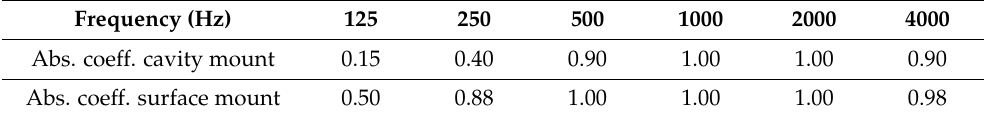
Table 4. Absorption coefficient of sound-absorbing wooden grooved acoustic panels applied to the walls (surface mount) and to the ceiling (cavity mount) of the room access space.